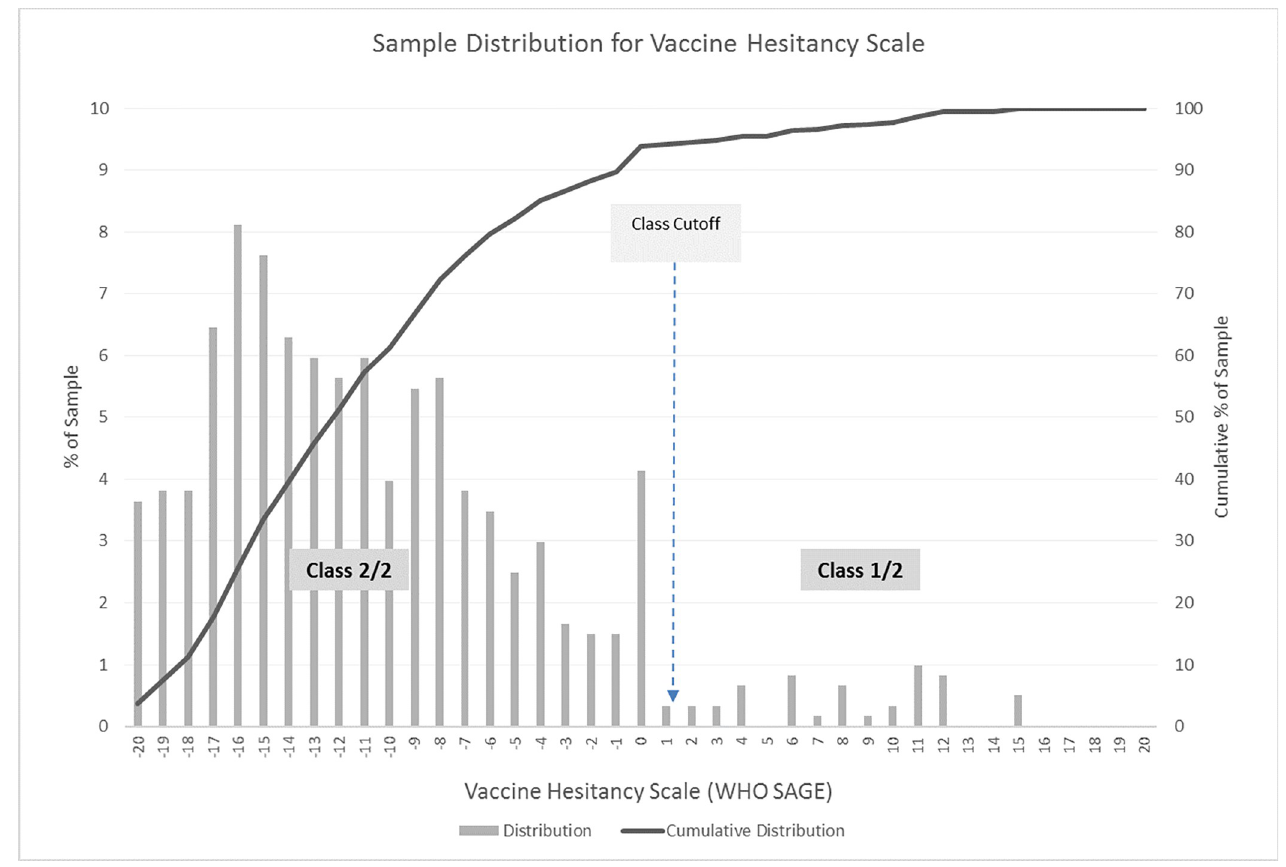
Fig 1. Sample distribution for vaccine hesitancy